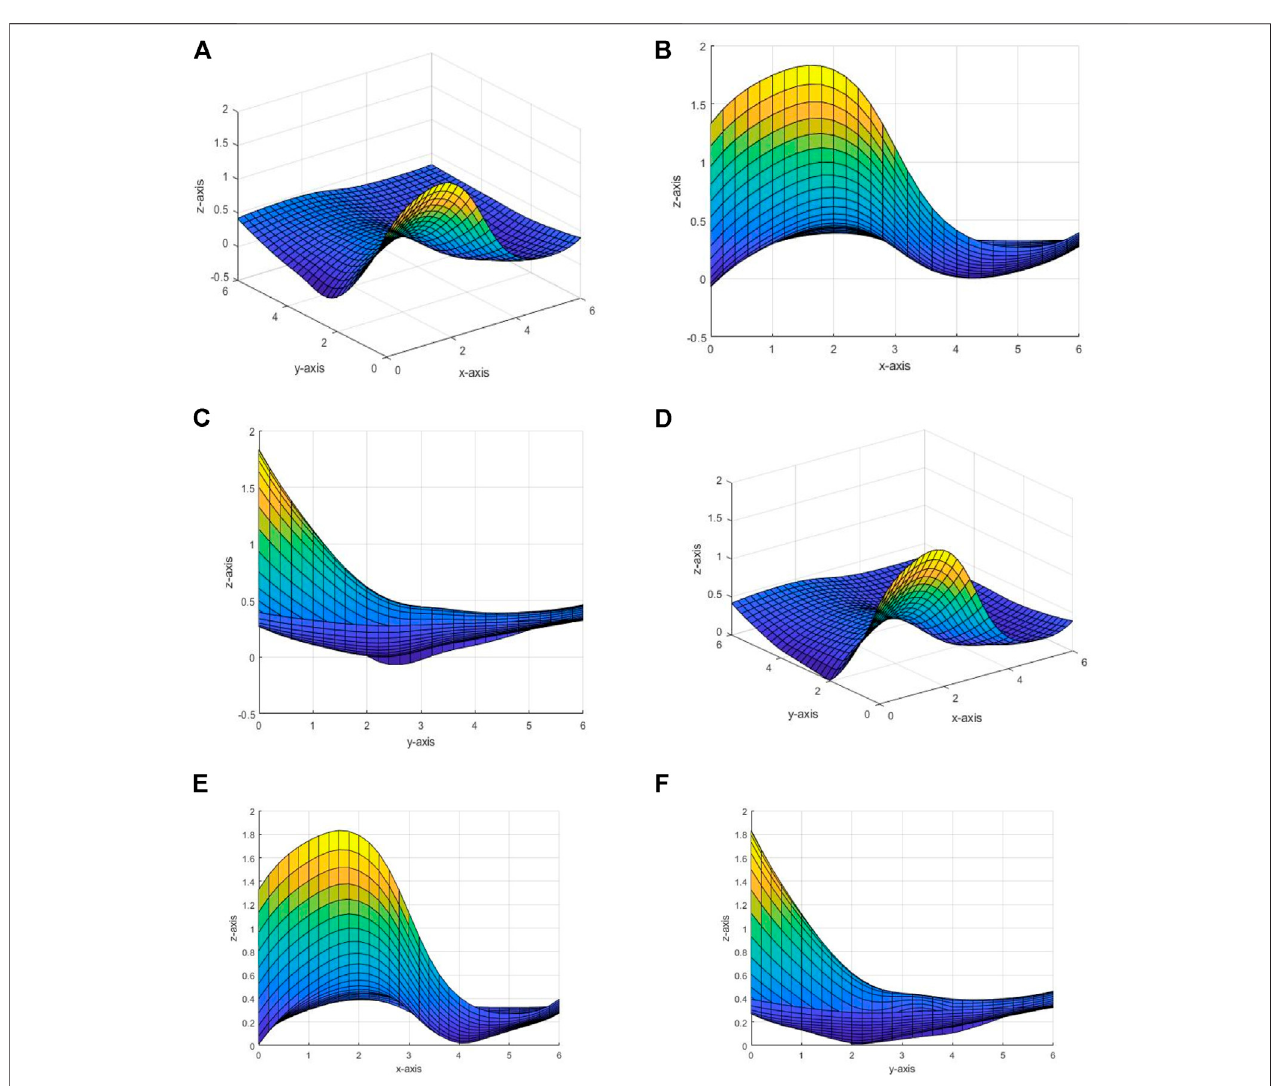
FIGURE 6 | Interpolating surface for Example 2. (A) Default surface. (B) xz-view for (A) . (C) yz-view for (A) . (D) The proposed scheme. (E) xz-view for (D) . (F) yz- view for (D) . (G) Other view for (D) . (H) Karim et al. [36]. (I) Abbas et al. [1].